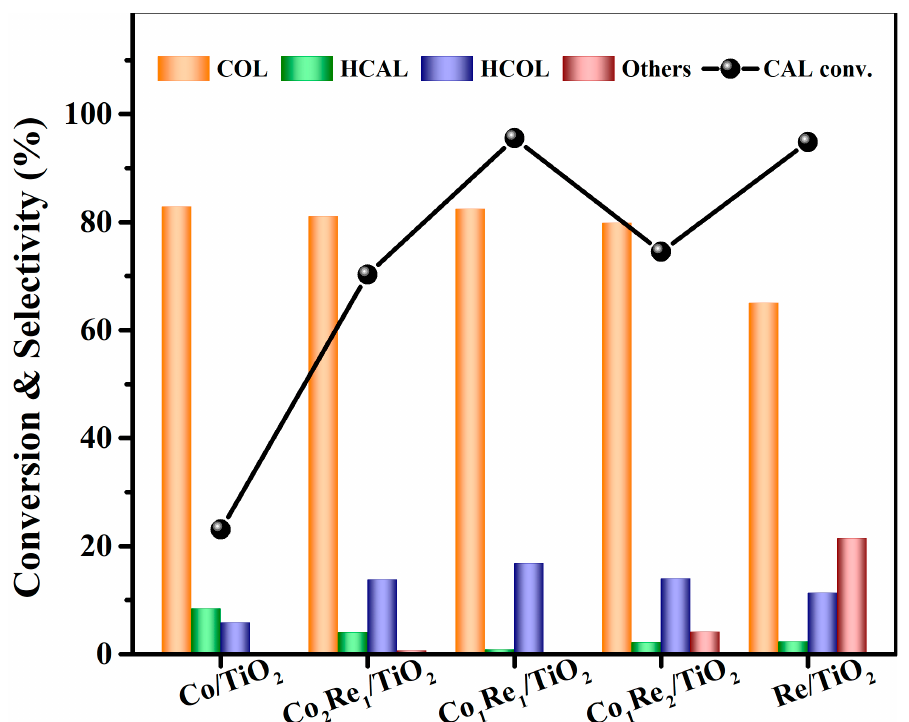
Figure 1. Hydrogenation of CAL to COL over various CoRe/TiO 2 catalysts. Reaction conditions: 3 mmol CAL, 80 mg catalyst, 10 mL isopropanol, 160 °C, 12 h. Others: allylbenzene, isopropenylben- zene, 1,1 ′ -(1,5-hexadiene-1,6-diyl)bisbenzene and other unknown by-products.